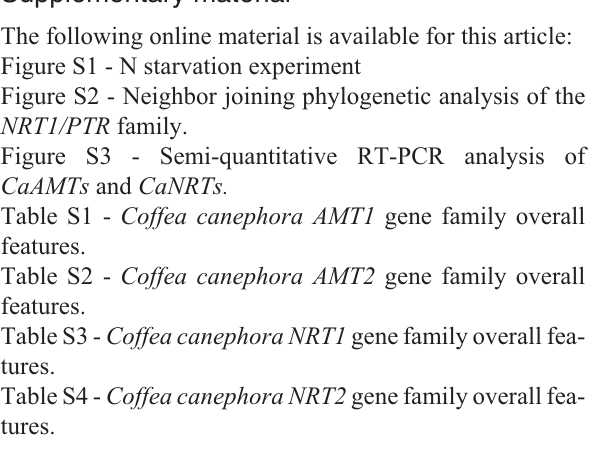
Figure S1 - N starvation experiment Figure S2 - Neighbor joining phylogenetic analysis of the NRT1/PTR family. Figure S3 - Semi-quantitative RT-PCR analysis of CaAMTs and